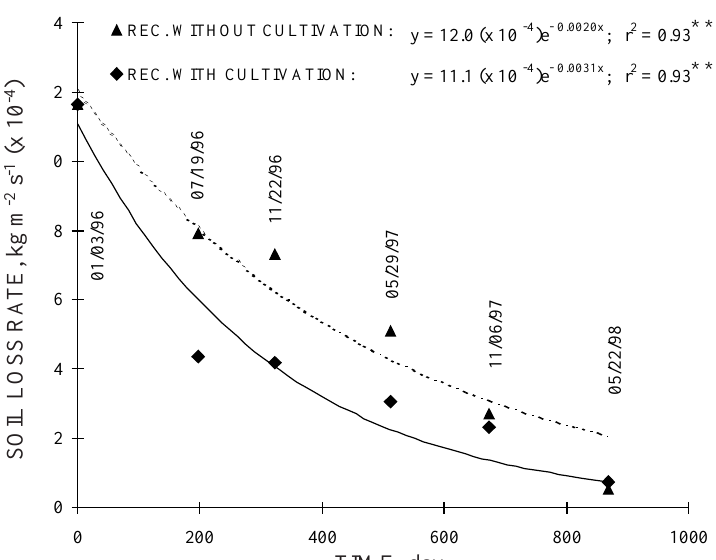
Figure 5. Soil loss rate at steady-runoff as a function of time in the reconsolidating soil